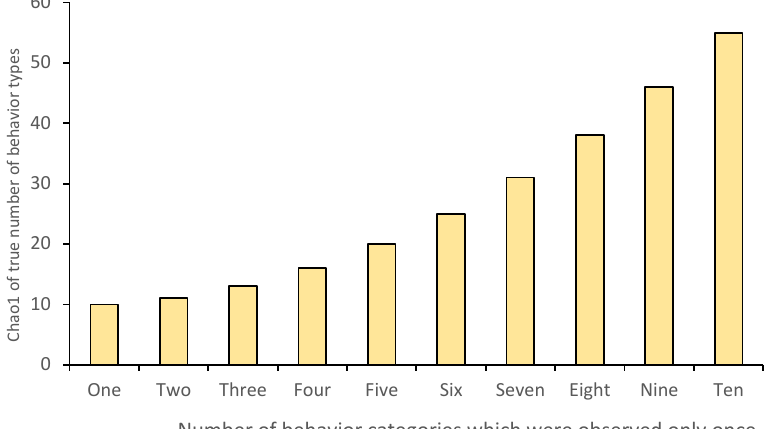
Figure 7. Simulated observations where ten categories of behavior are observed. The figure shows the effect on Chao1 values of an increasing number of observations where a behavior occurs only once in the observation period.